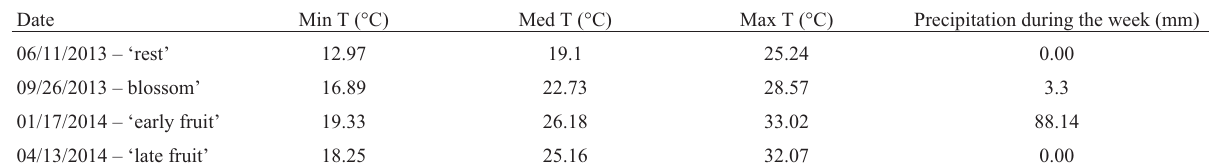
Table 3 - Temperature at the time of sample collection and precipitation during the week of sample collection.